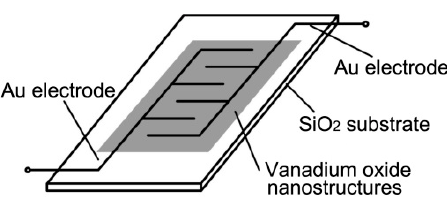
Figure 1. A schematic of the sensor substrate, the patterned gold electrodes and the sensing